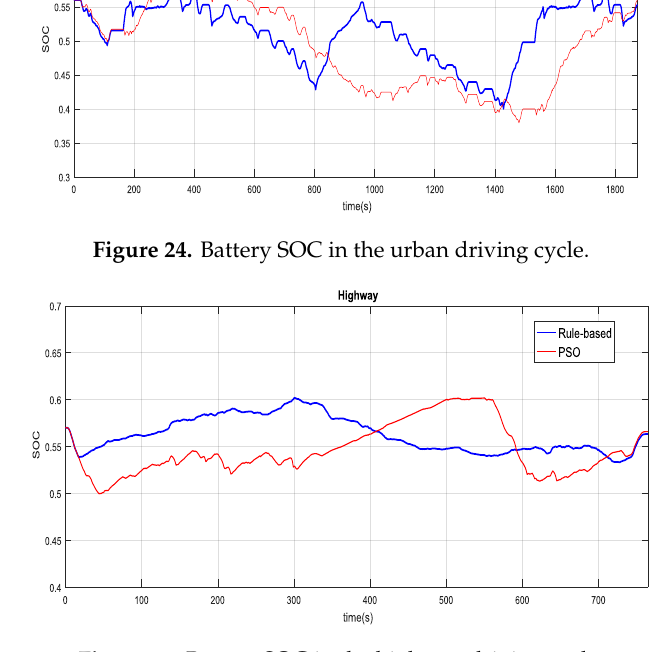
Figure 25. Battery SOC in the highway driving cycle.